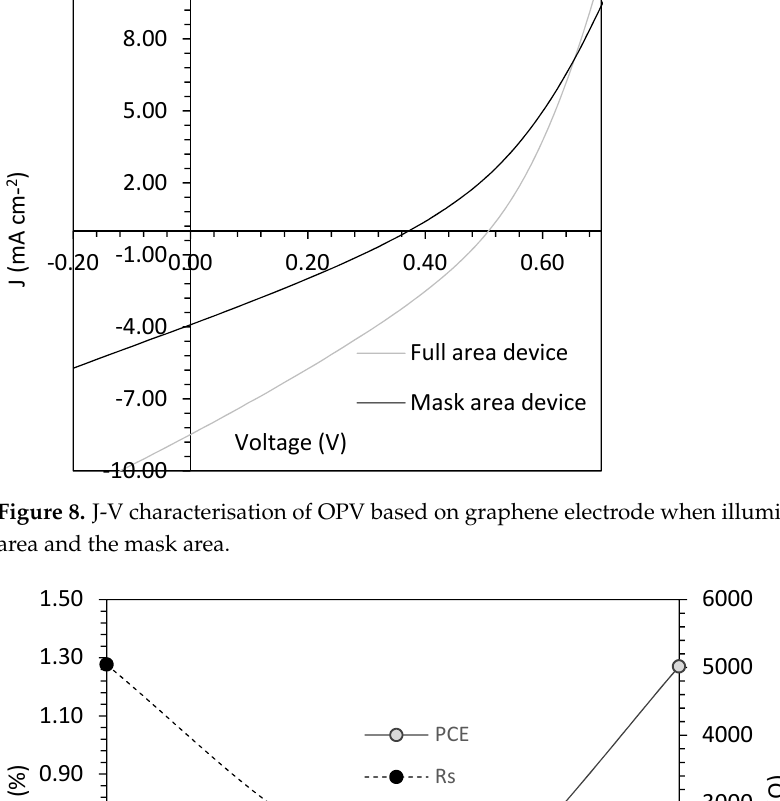
11 of 16 Figure 7. ( a ) Dispersion of total real part resistance of impedance versus frequency for OPVs based on graphene and ITO as window electrodes, and ( b ) the linear J variations vs. V for graphene-based device, and ITO-based OPV device. To investigate the practicality of area dependence of using graphene films as window electrodes in OPV devices, various areas of graphene devices were fabricated and illumi- nated under masks of varying sizes. This experiment was undertaken to determine the viability of low-temperature graphene electrodes for electronic applications. Initially in this study, devices with an active area of 5 mm 2 were prepared and their performances were characterised under full illumination and the standard mask area of 3.8 mm 2 . Typical